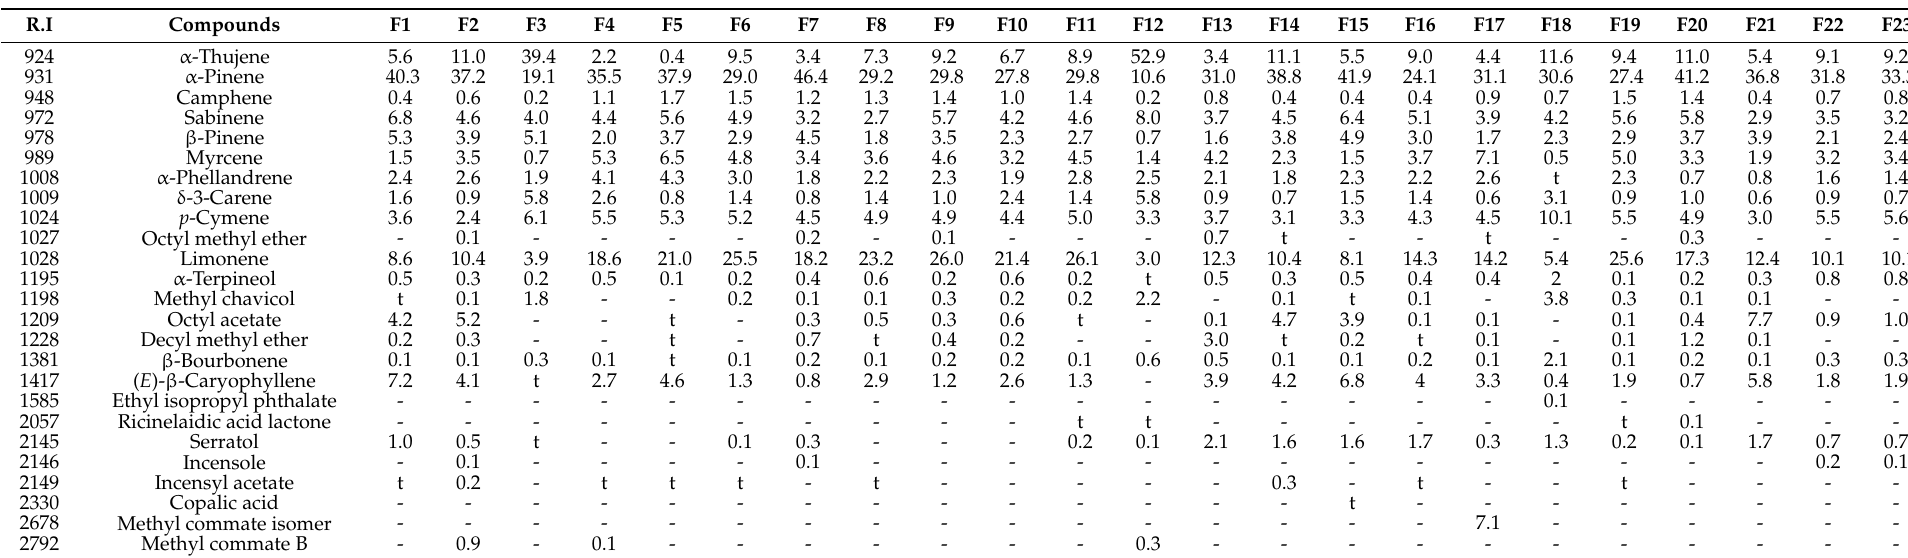
Table 1. The selected constituents of the commercial and lab-distilled frankincense ( B. carteri ) essential